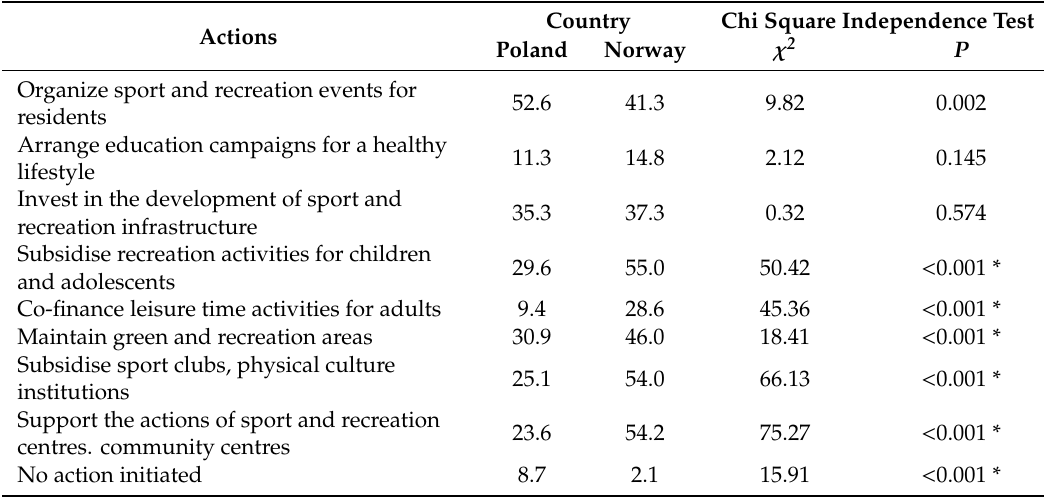
Table 4. Local government activities for PA development x country of residence ( n %).